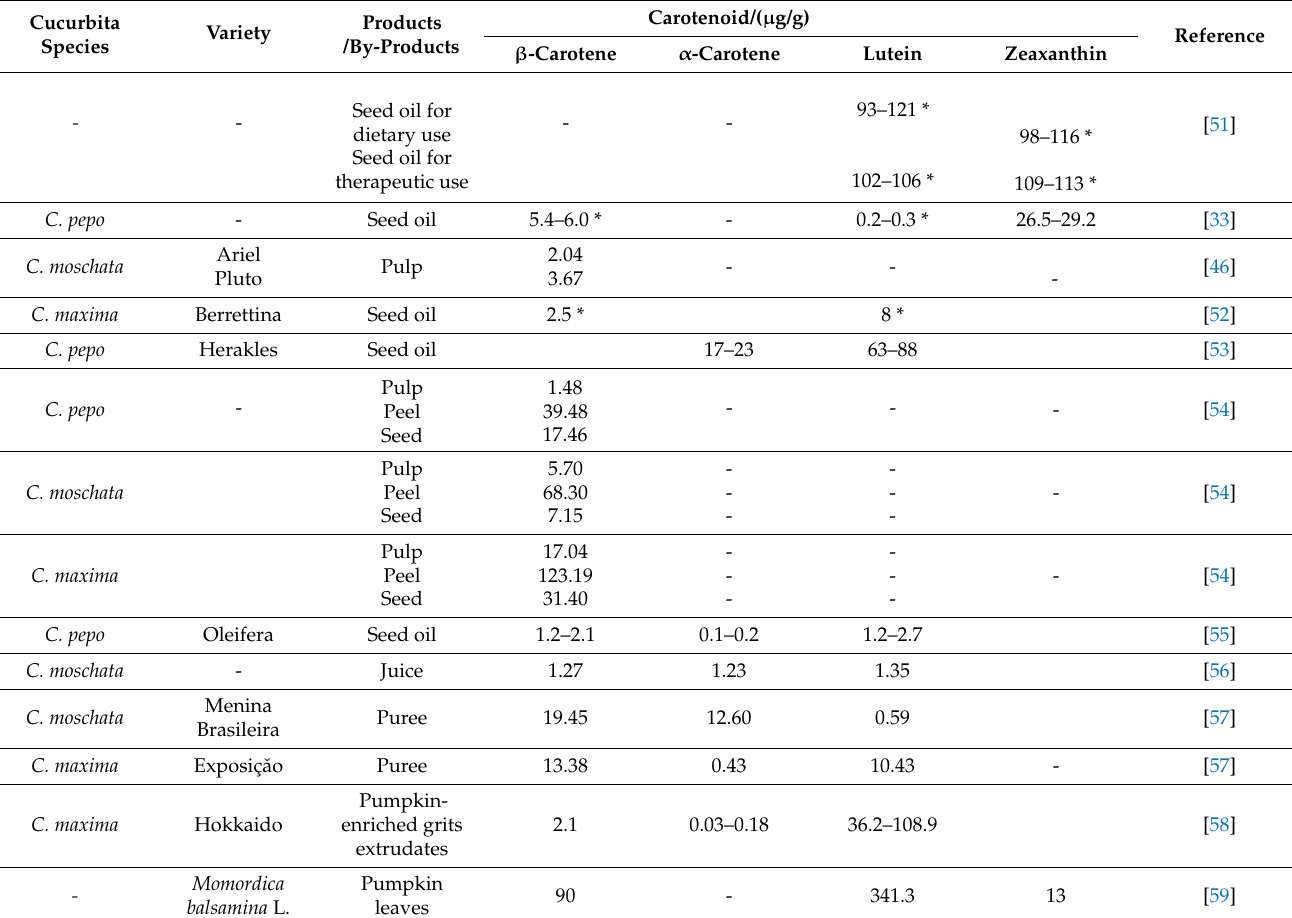
Table 3. Content of major carotenoids in pumpkin products and